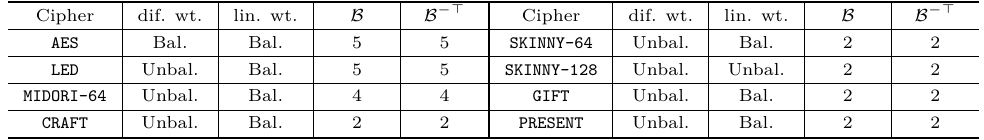
Table 3: Unbalanced Weights and Branch Numbers of the Considered